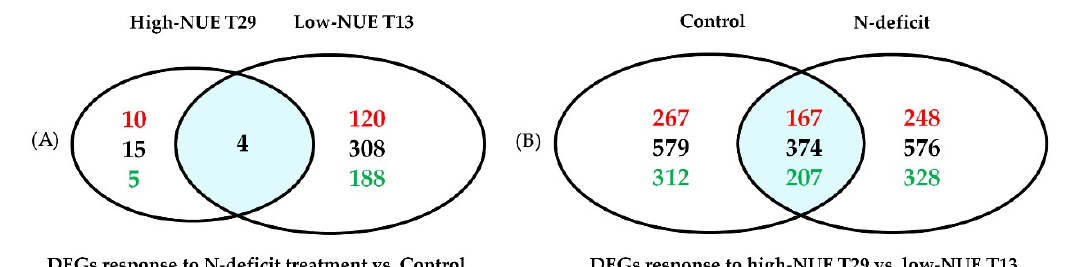
Figure 3. Venn diagram of DEGs in di ff erent treatments. The sum of the numbers in each large circle represents the total number of di ff erentially expressed genes between combinations; the overlapping part of the circles colored with cyan represents common DEGs between combinations. Black numbers represent the total DEG number. ( A ) DEGs responding to N deficit compared to control, in which red numbers represent upregulated DEGs and green numbers represent downregulated DEGs. ( B ) DEGs responding to di ff erent genotypes, in which red numbers represent DEG numbers in high-NUE T29 and green numbers represent DEG numbers in low-NUE